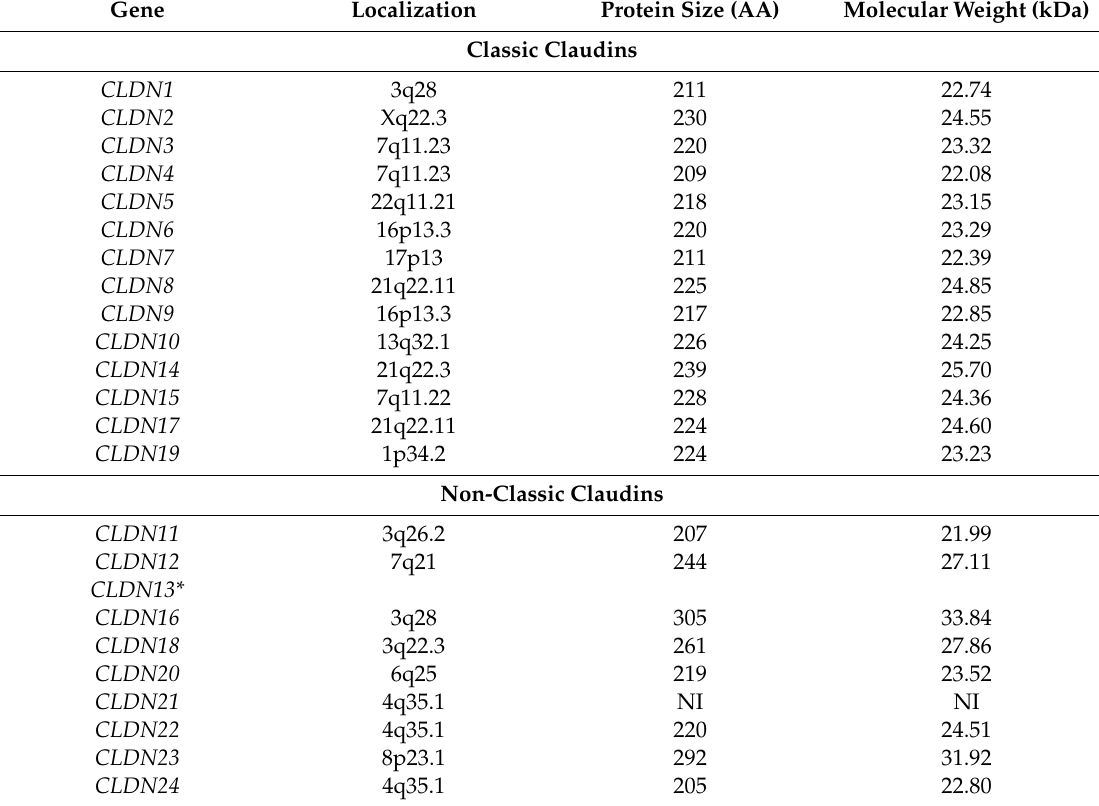
Table 1. Division of claudins based on the sequence similarity and their chromosomal localization, protein size, and molecular